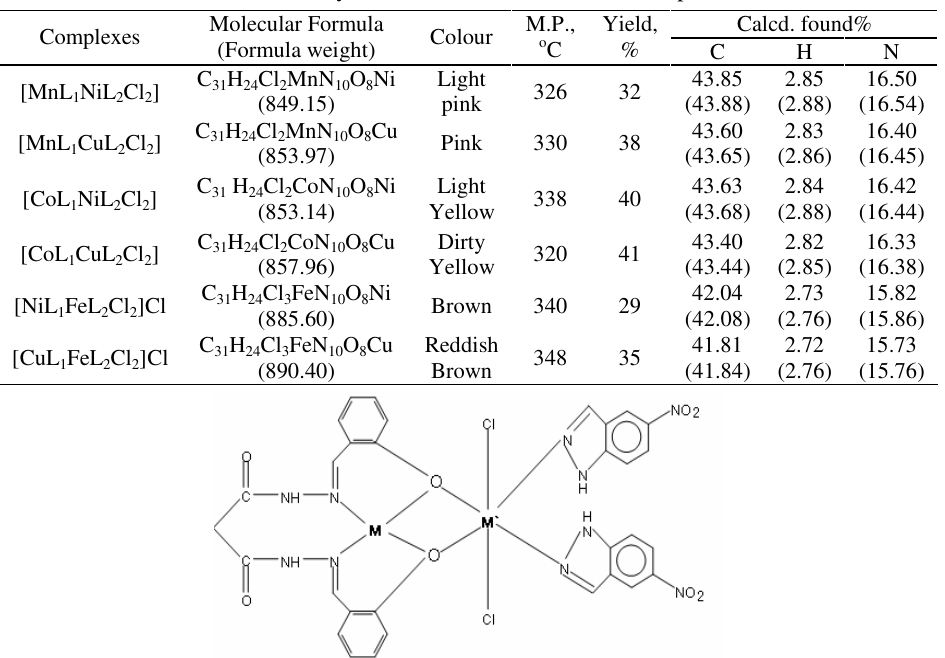
Figure 1. Heterobinuclear complexes of the type [ML